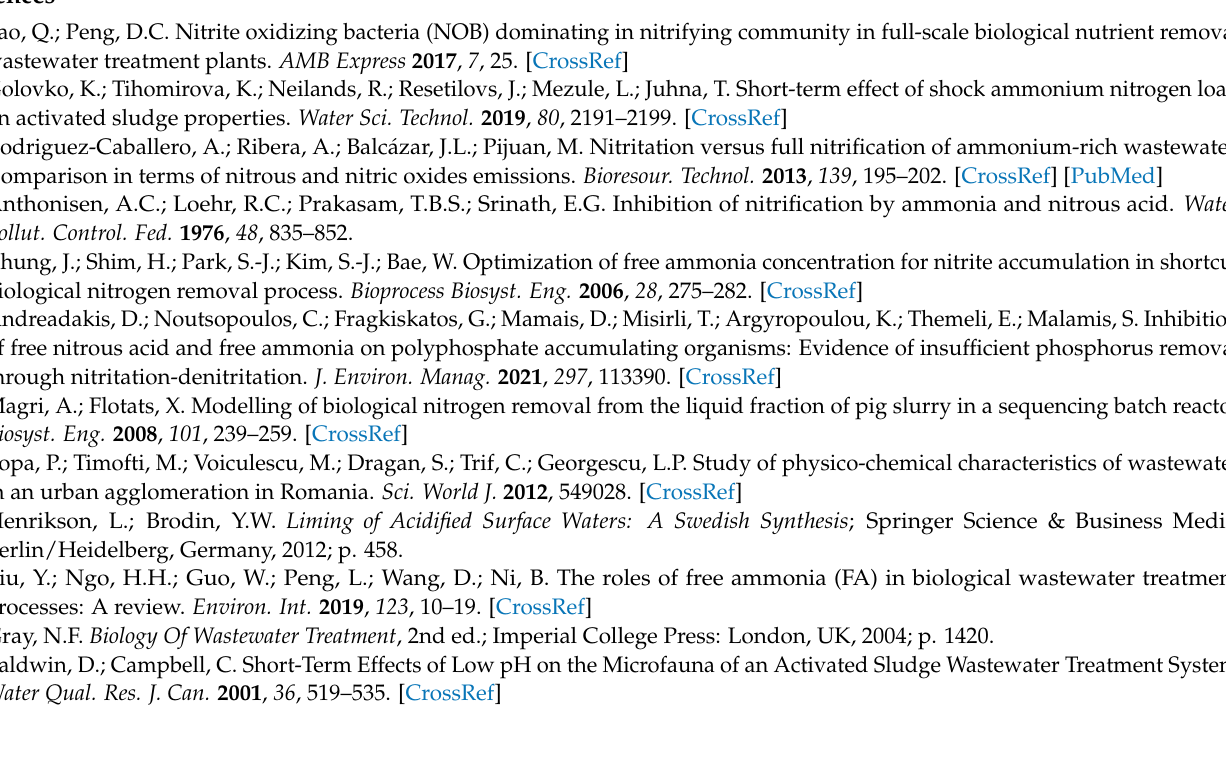
Figure S5: Changes in SVI30 in acidic and alkaline pH reactors (n = 3); Figure S6: The schematic diagram of experimental set-up